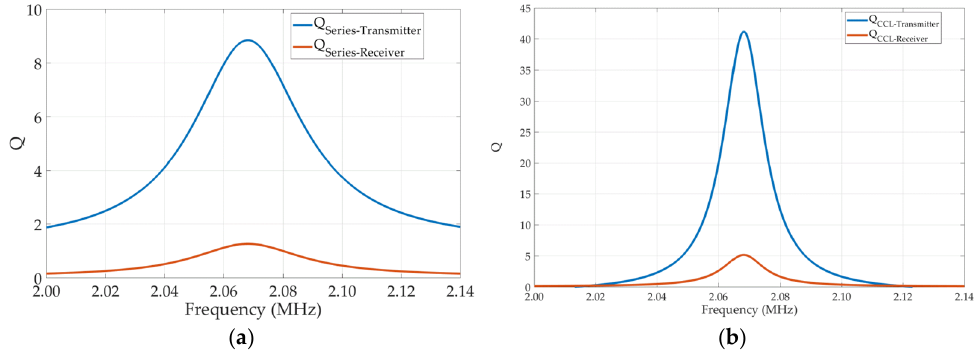
Figure 6. Q factor on the transmitter and receiver for ( a ) the series circuits and ( b ) CCL hybrid cir- cuits.